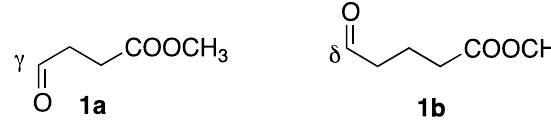
Figure 1. Oxoesters examined in this study.